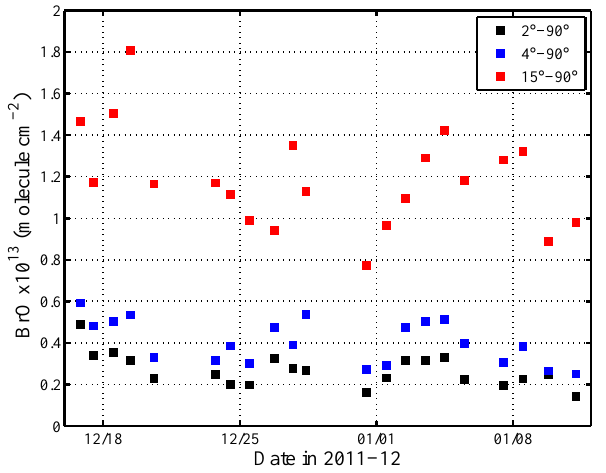
Figure 5. Median daily values of MAX–DOAS BrO vertical amounts from Dome C during sunny days or part days only, after subtracting zenith amounts (see text). Reference spectrum from near noon on 18 December 2011 until 6 January 2012, then from near noon on 7 January 2012. The apparently larger vertical amounts at higher elevations show that much of the BrO is in the free tropo-